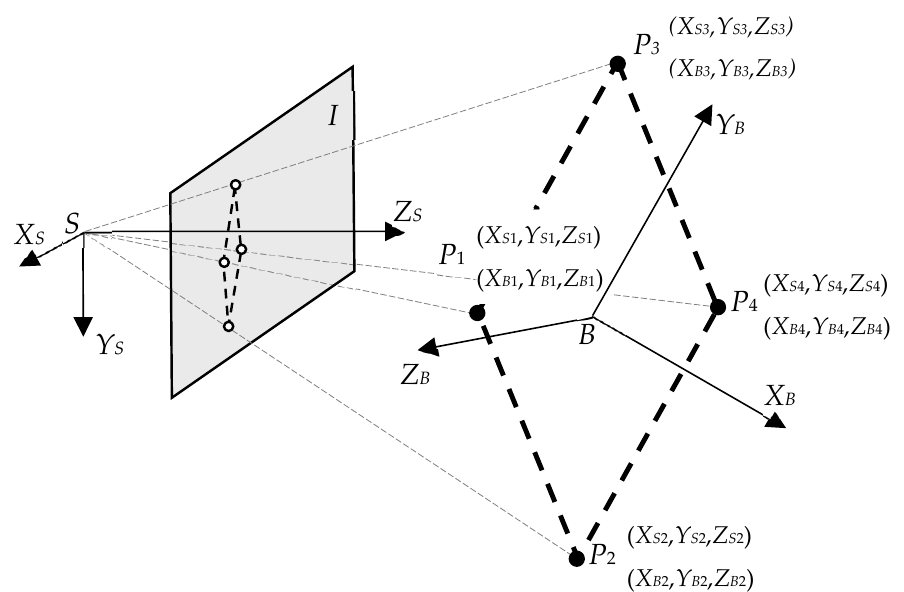
Figure 3. Camera system, object system and the four vertices’ coordinates in the two systems.